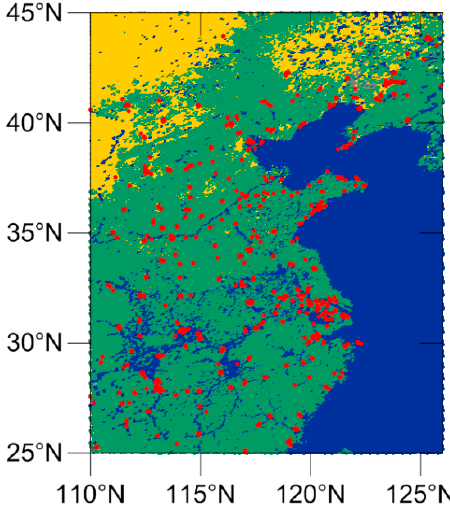
Figure 1. The research region of Eastern China. Green, yellow, and blue backgrounds show dark, bright, and water surfaces on May 29, 2015, respectively. Red dots are environmental monitoring stations.